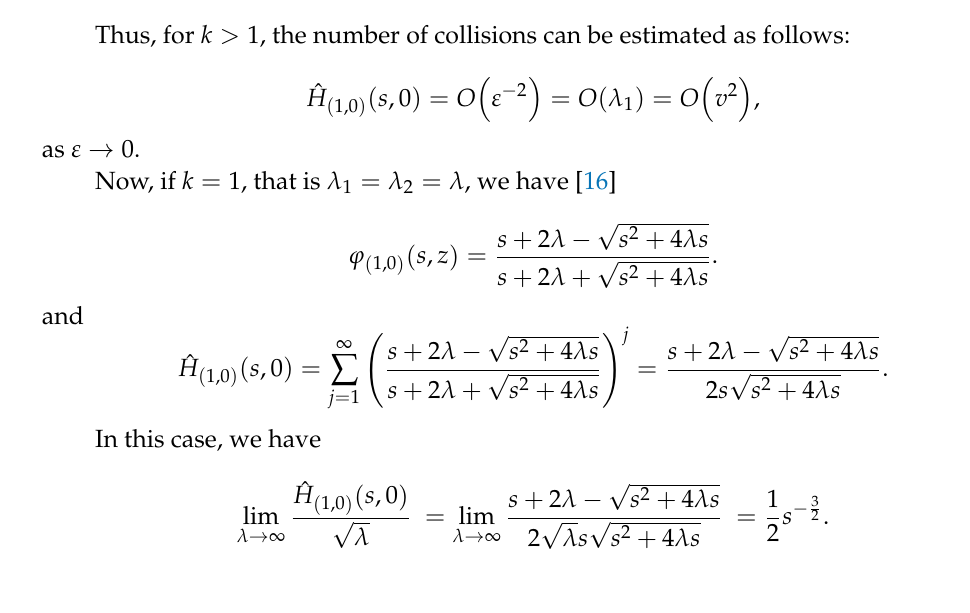
Figure 1. Numerical inverse Laplace transform of The limit value is from Equation (14) and k =